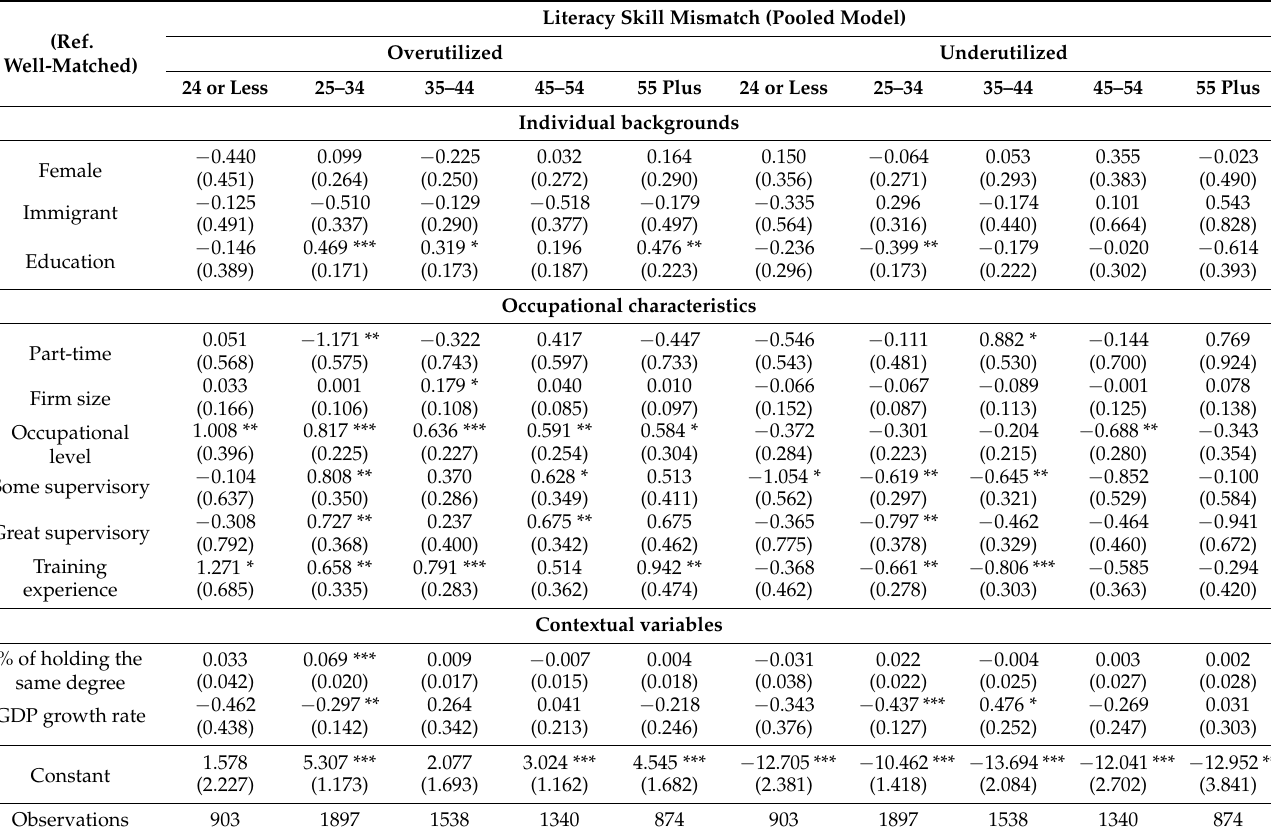
Table 8. Pooled model by age (literacy